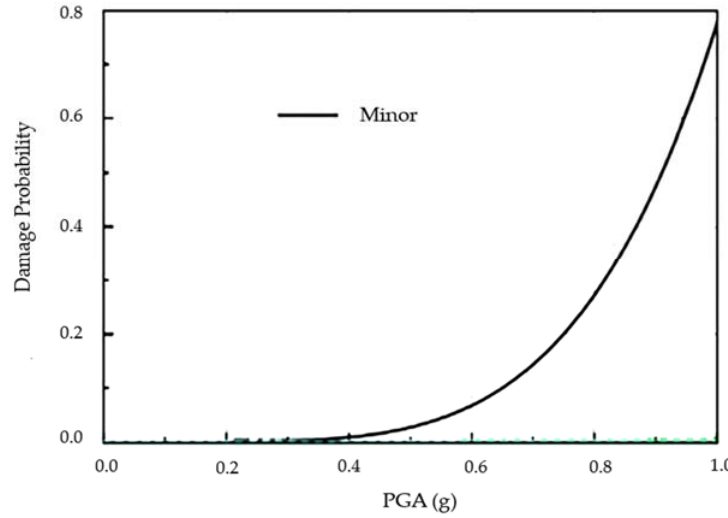
Figure 5. The seismic fragility curves of the pier.